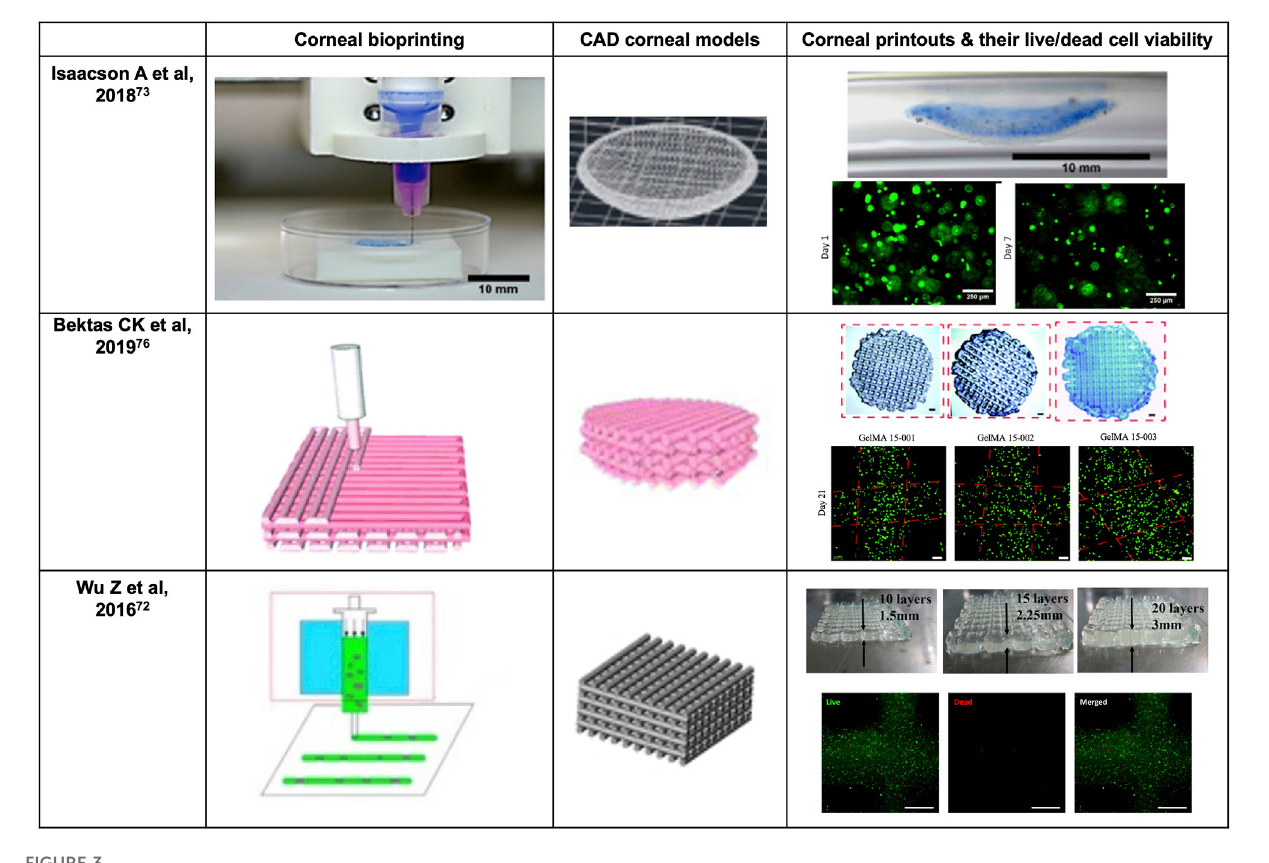
FIGURE 3 Representative progress on 3D bioprinting of